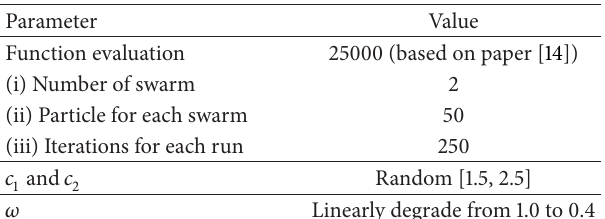
Table 1: Algorithm